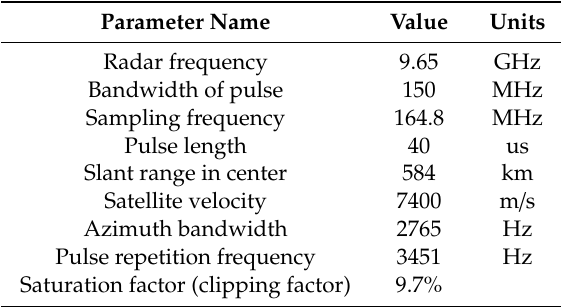
Table 2. Echo simulation parameters of